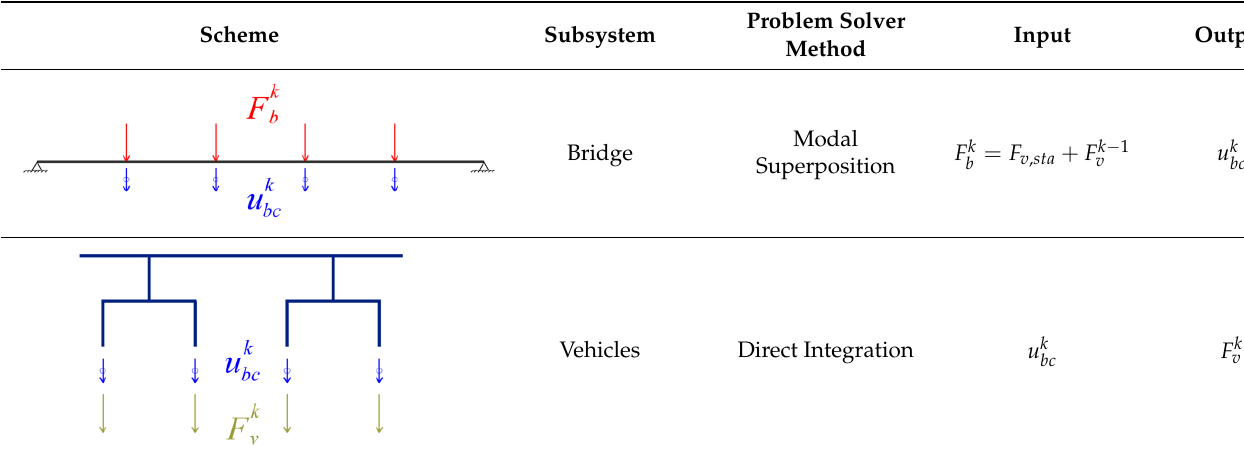
Table 3. Iterative methodology for solving the train-bridge dynamic interaction problem. Scheme